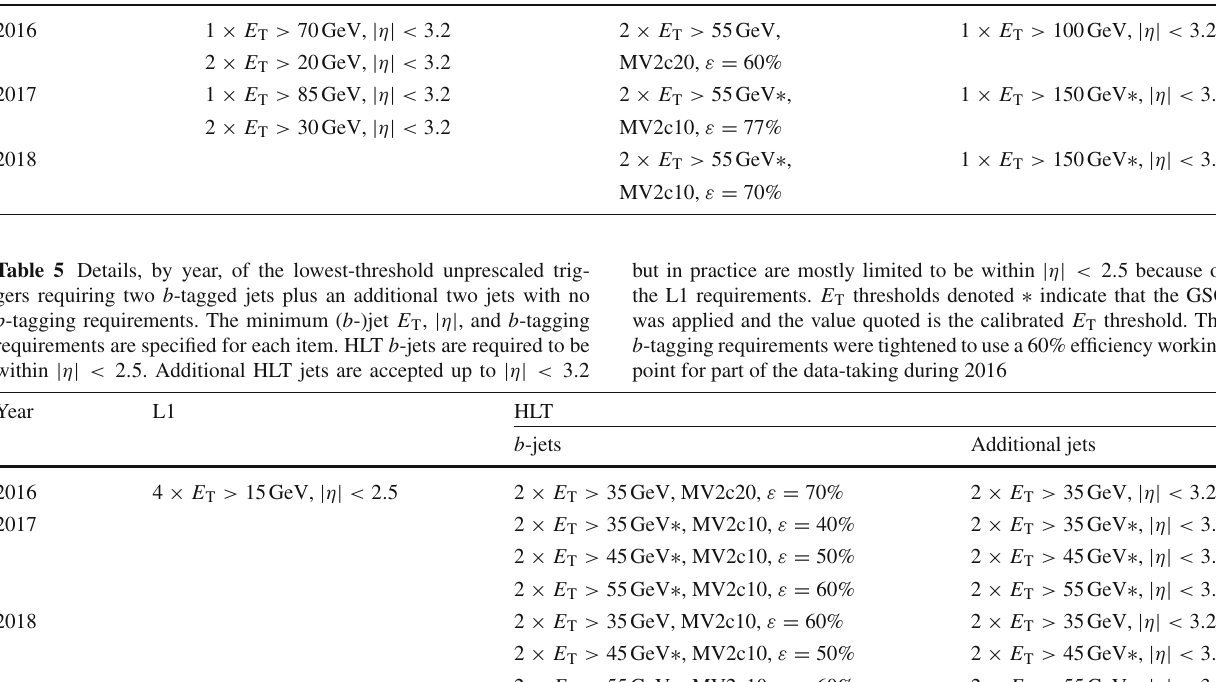
( b -)jet E T , | η | , and b -tagging requirements are specified for each item. HLT b -jets are required to be within | η | < 2 . 5. E T thresholds denoted ∗ indicate that the GSC was applied and the value quoted is the calibrated E